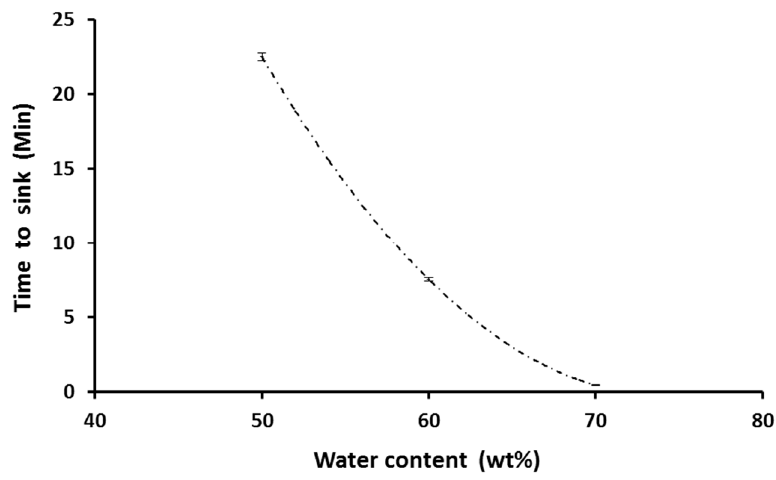
Figure 3. Influence of tap water content (in wt%) on steel ball sinking time.